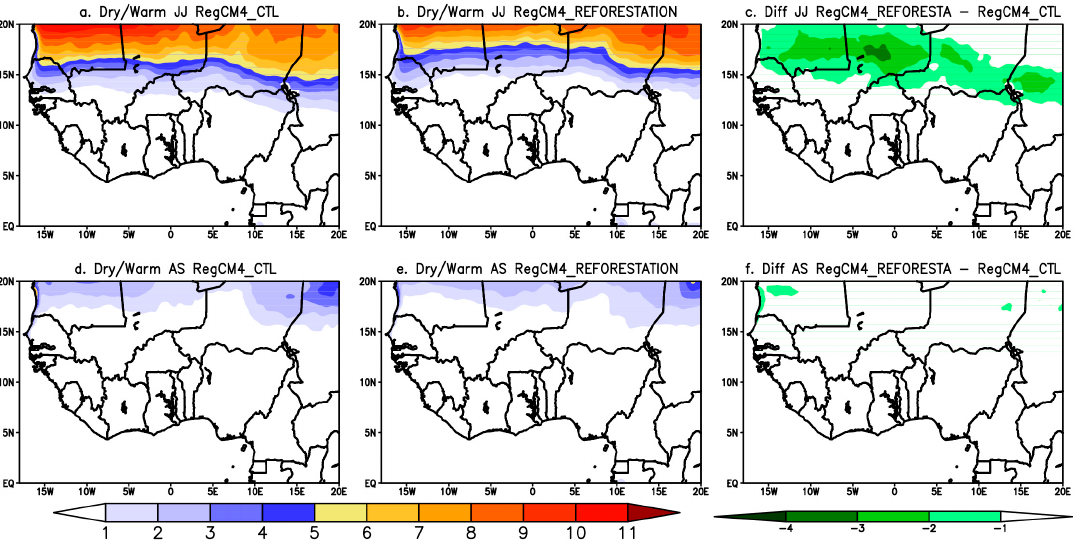
Figure 9. Number (expressed in days) of extreme dry/warm days during the June–July (JJ) and August–September (AS) periods averaged from 1990 to 2009 over West Africa for: ( a , d ) RegCM4_CTL; ( b , e ) RegCM4_REFORESTATION and ( c , f ) RegCM4_REFORESTATION—RegCM4_CTL.